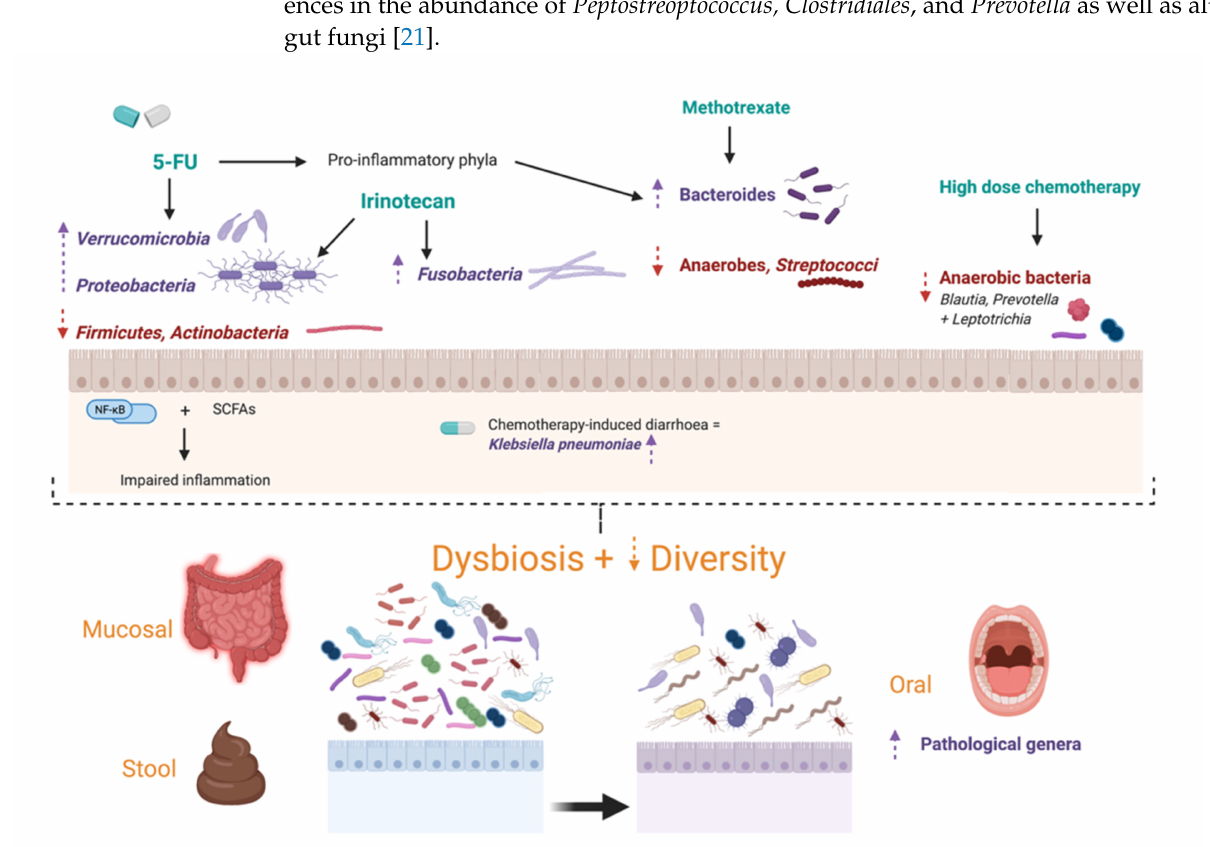
Figure 2. The impact of chemotherapy and immunotherapy on the microbiome. Dysbiosis with a reduction in diversity and operational taxonomic units is evidenced following different treatment regimes. This dysbiosis occur in colon mucosa, stool and oral cavity of the treated patients. The oral dysbiosis includes the enrichment of pathological genera such as Neisseria spp. The gut mucosal and stool dysbiosis include a specific shift towards pro-inflammatory bacteria with a reduction of anaerobic bacteria. Dotted arrows represent the shift in microbiome and bold arrows represent the effect of chemotherapy on the microbiome